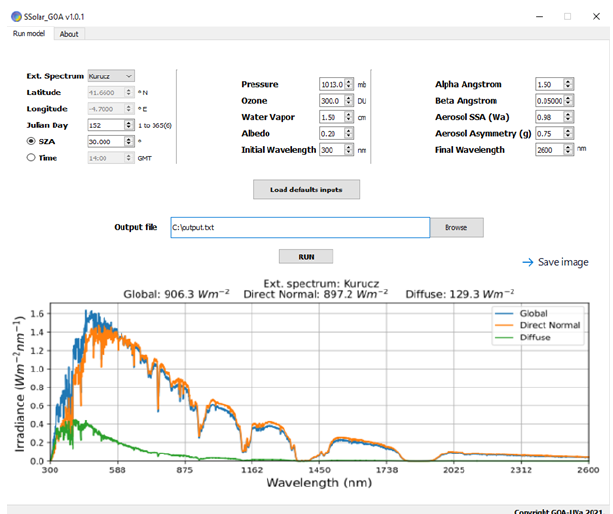
Figure 1. Screenshot of SSolar-GOA v1.0.1 with default inputs